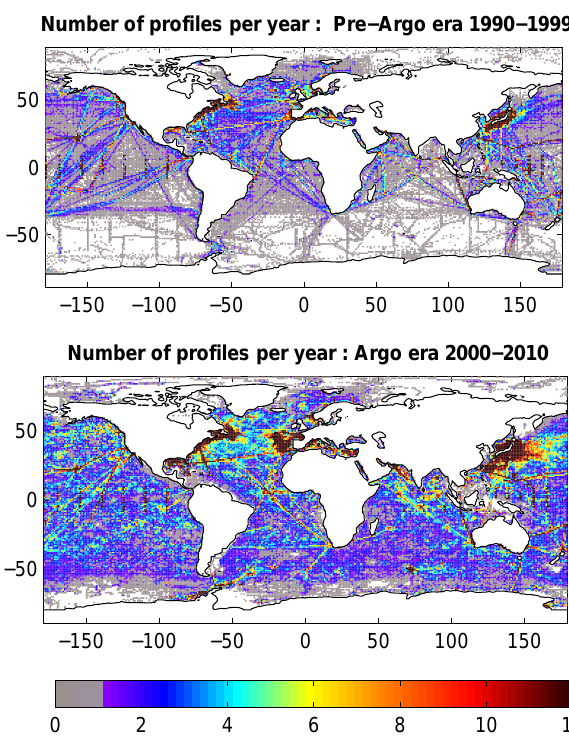
Fig. 1. Number of profiles per year in 1 ◦ × 1 ◦ boxes for the pe- riod 1990–1999 (upper panel) and 2000–2010 (lower panel) in the CORA3 database.